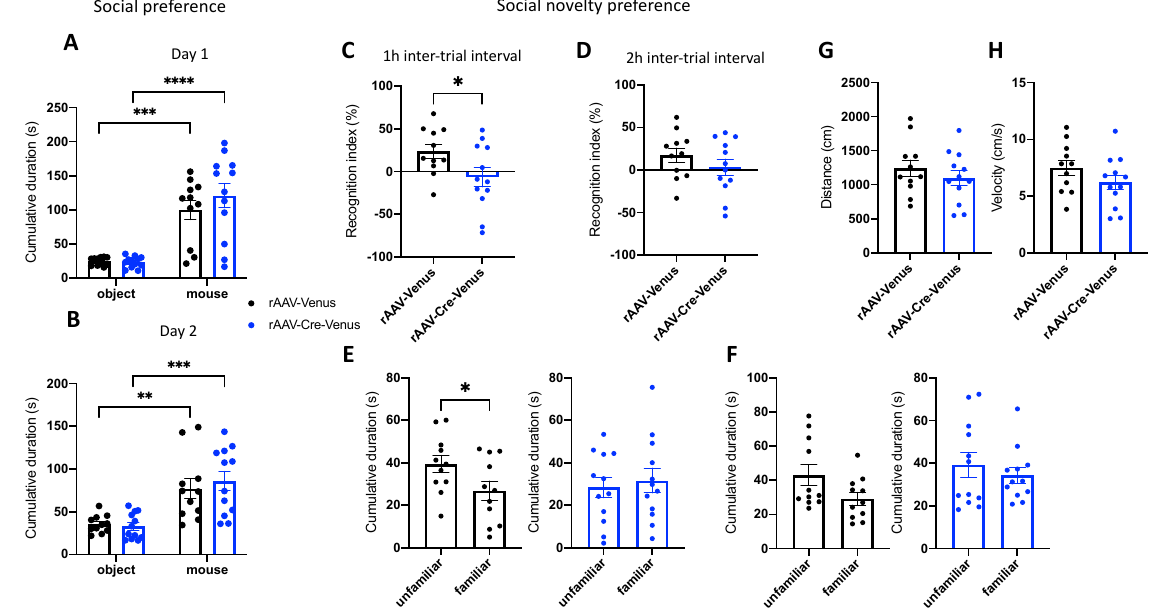
Figure 6. Social recognition memory in 6-month-old mice. ( A ) Social preference on Day 1 and ( B ) Day 2 of the social preference task. Social memory as social novelty preference ( C , E ) after 1 h on Day 1 and ( D , F ) 2 h on Day 2 inter-trial intervals. Locomotor activity of mice measured as ( G ) distance travelled and ( H ) velocity. Individual data points, and mean value ± SEM are shown. Two-way ANOVA, followed by Bonferroni post-hoc test for the social preference and Student’s unpaired and paired t -test for the social novelty preference. * p < 0.05; ** p < 0.01; *** p < 0.001; **** p <